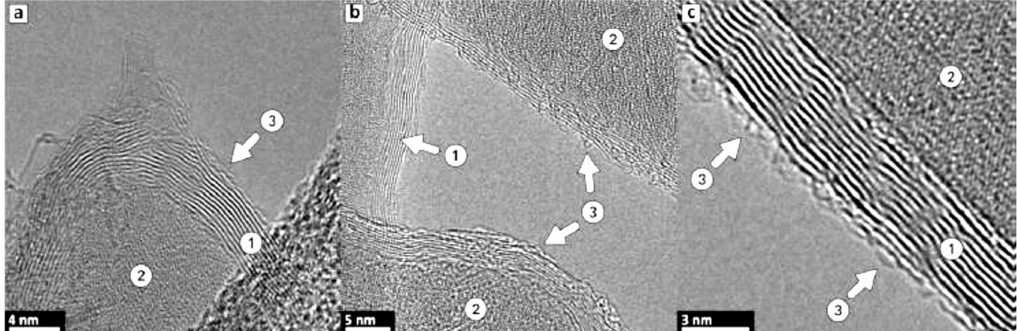
Figure 3. TEM images of graphene coatings around the alumina nanofiber (pictures ( a – c ) represent different locations). Label (1) points to stacked carbon layers, (2) marks a substrate nanofiber, and (3) shows outer highly defective